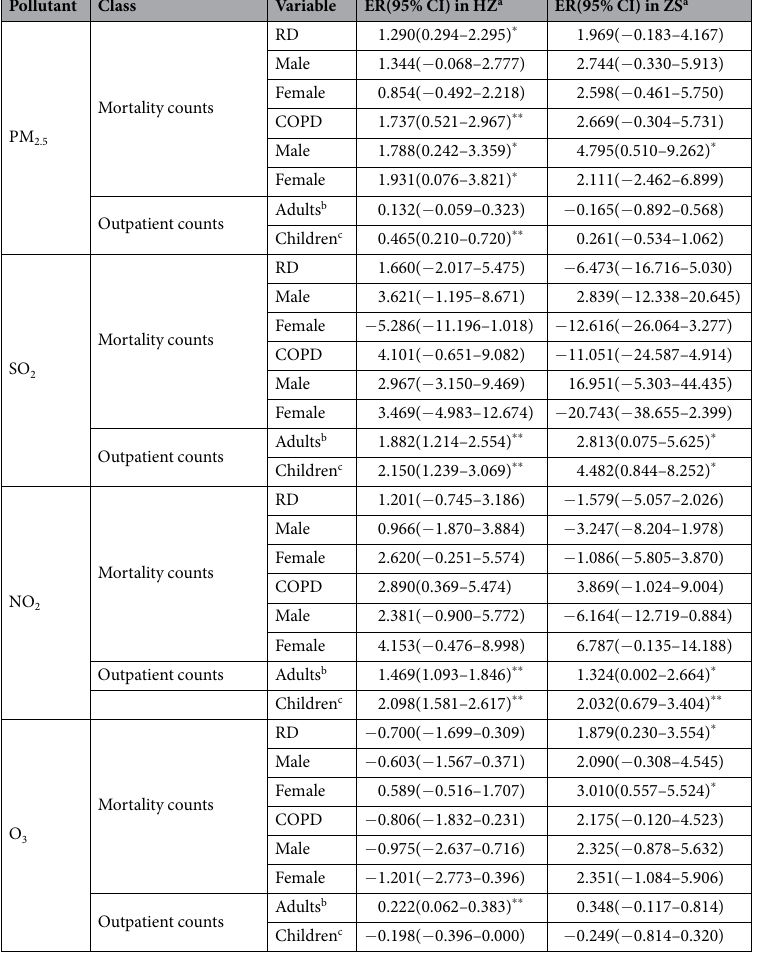
Table 5. Excess Risk of respiratory mortalities and outpatients per 10 μ g/m 3 increase of air pollutants in both cities: multiple-pollutant model. * P < 0.05, ** P < 0.01 (Excess Risk is adjusted for temperature, relative humidity and atmospheric pressure, day of week, time trend and other pollutants for mortality and hospital data, and public holiday only for hospital data); a Excess Risk (95% confidence interval); b RD in adults; c RD in